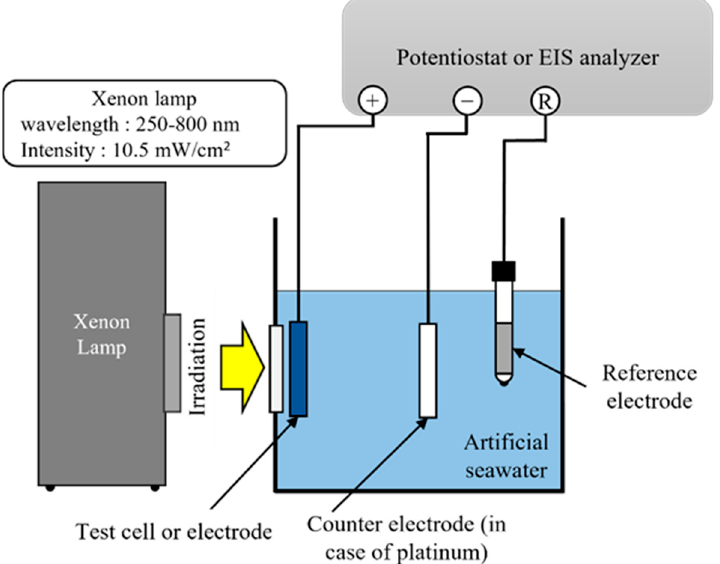
2 –copper oxides cell, and its image.